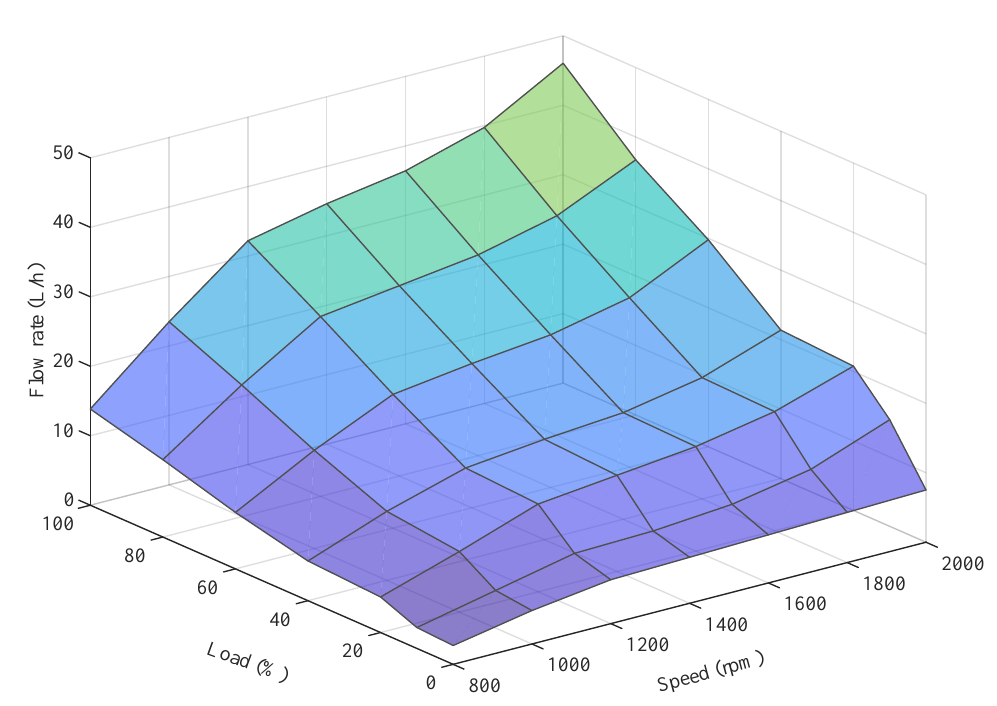
Figure 5. Fuel rate map of the diesel engine.